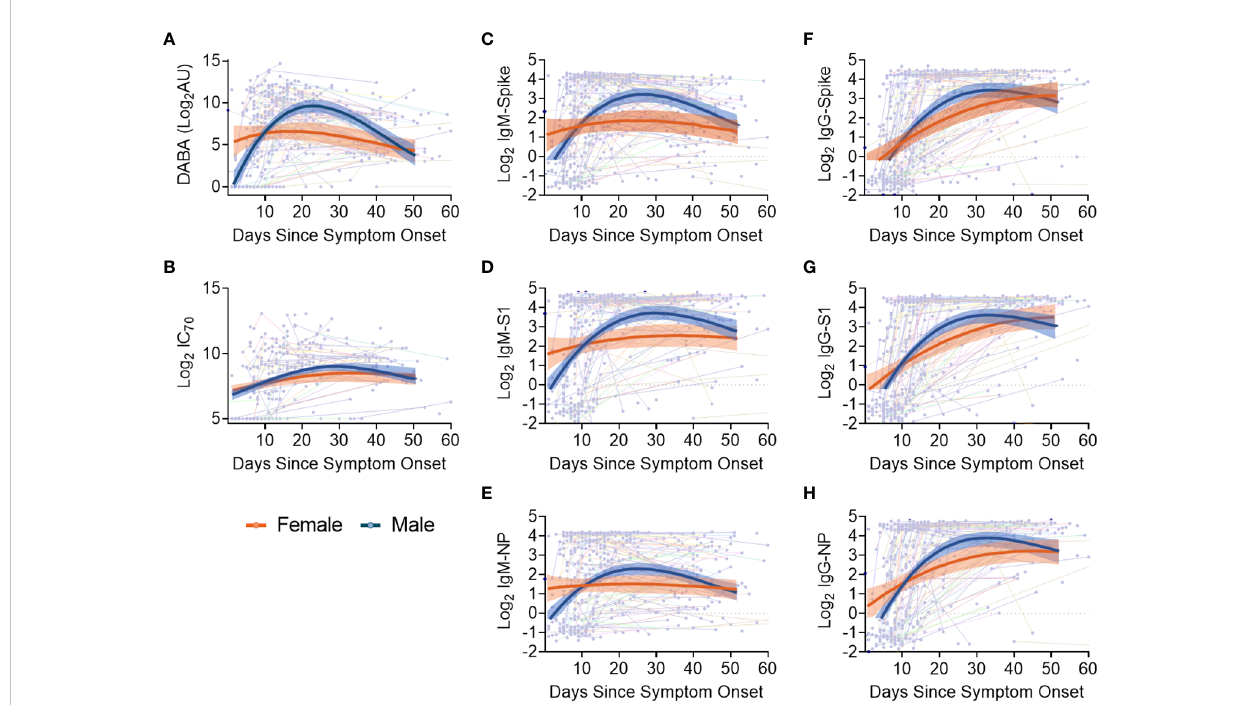
FIGURE 4 Evolution in time of antibody titres following disease onset by sex and subclass. (A) Anti-RBD titres. (B) nAb (IC 70 ) responses. (C-E) IgM binding responses against spike (C) , S1 (D) and NP (E) . (F-H) IgG binding responses against spike glycoprotein (F) , S1 (G) and NP (H) responses. The thin lines in background indicate individuals with longitudinal samplings with each dot representing a time point collection. For all panels, best- fi t curves with 95% con fi dence intervals are shown for females (orange) and males